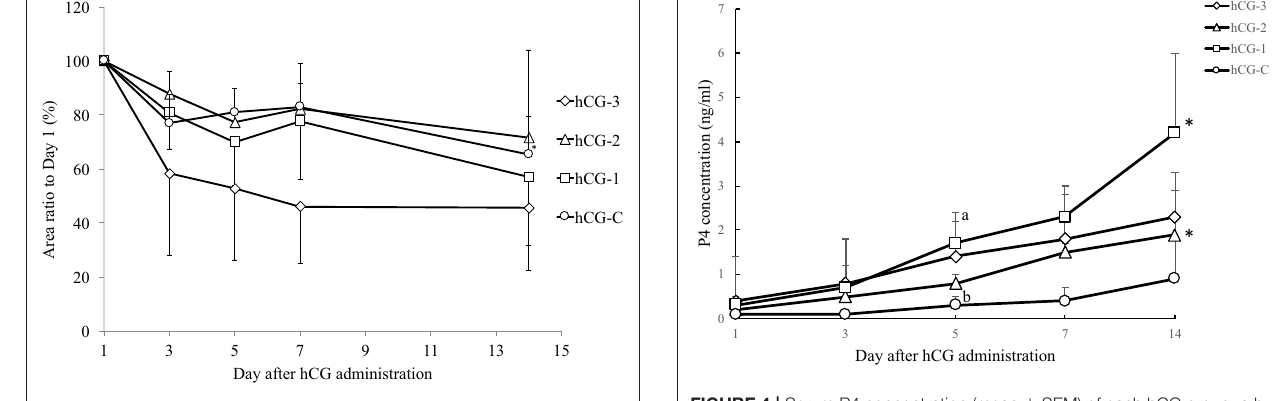
FIGURE 3 | Mean ( ± SEM) change in the area of cystic ovarian follicles in cows in each group. The area of the cystic follicle on day 1 was considered 100%. *Indicates significant reduction in cystic ovarian follicle area compared with day 1.